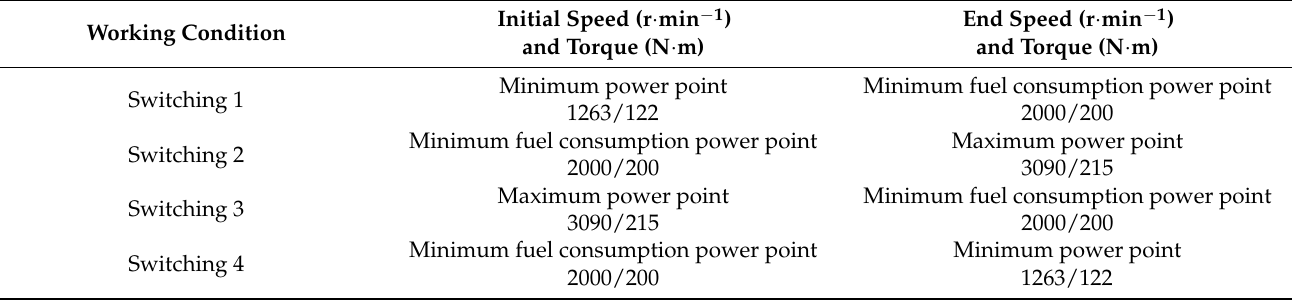
Table 4. Main test conditions.